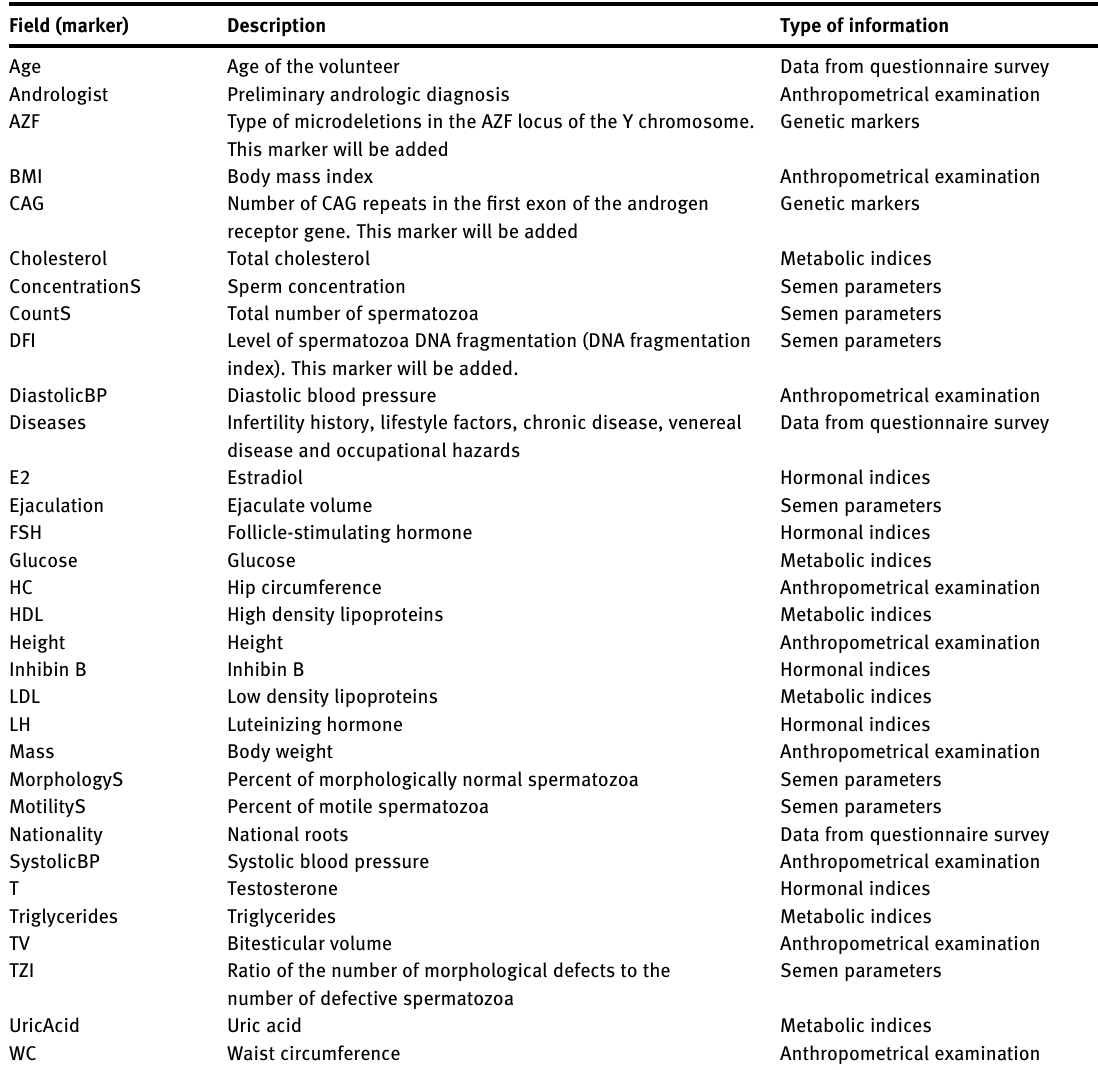
Table  : Description of the columns in the Table “ Men ” , associated with fertility. Field